Question: Write the caption for this figure.
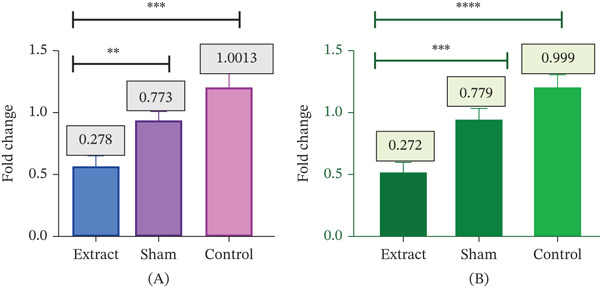
Answer: Fold change analysis of ureC (left) and uafA (right) gene expression in SS2 isolate treated with ethanolic extract at sub‐MIC concentration, sham, and control. Significant downregulation of both genes was observed in the extract‐treated groups compared with the control, as indicated by asterisks ( p < 0.05).